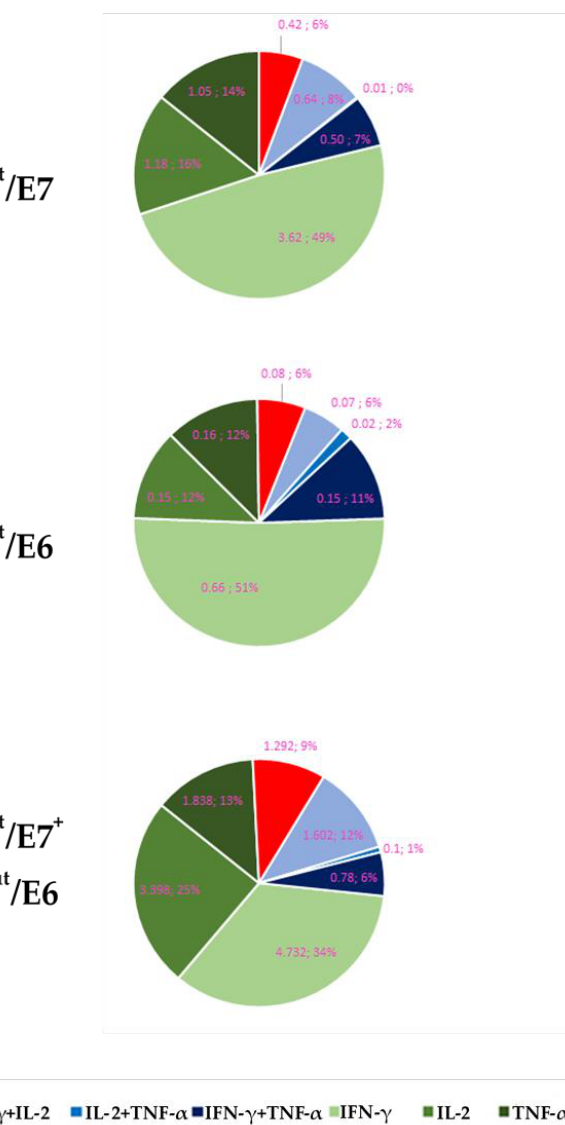
Figure 3. Intracellular cytokine staining analysis on CD8 + T cells from injected mice. ( A ) Percentages of CD8 + T cells expressing IFN- γ , IL-2, and TNF- α over the total of CD8 + T cells within splenocytes isolated from each mouse injected with the indicated DNA vectors. A total of 2.5 × 10 5 splenocytes were incubated o.n. with or without 5 μ g/mL of either unrelated or E6+E7-specific nonamers. Shown are mean values +SD of the absolute percentages of positive CD8 + T cells within total CD8 + T cells from cultures treated with specific peptides after subtraction of values detected in CD8 + T cells from cultures treated with unrelated peptide. ( B ) Pie charts indicating the means of both absolute (i.e., over the total of analyzed CD8 + T cells) and relative percentages of CD8 + T cells expressing cytokine combinations within pools of splenocytes from mice injected with the indicated vectors. Percentages were calculated after subtraction of values detected in homologous cultures treated with unrelated peptides. Values detected with splenocytes from mice injected with control vectors were below the sensitivity threshold of the assay. The results are representative of two independent experiments.